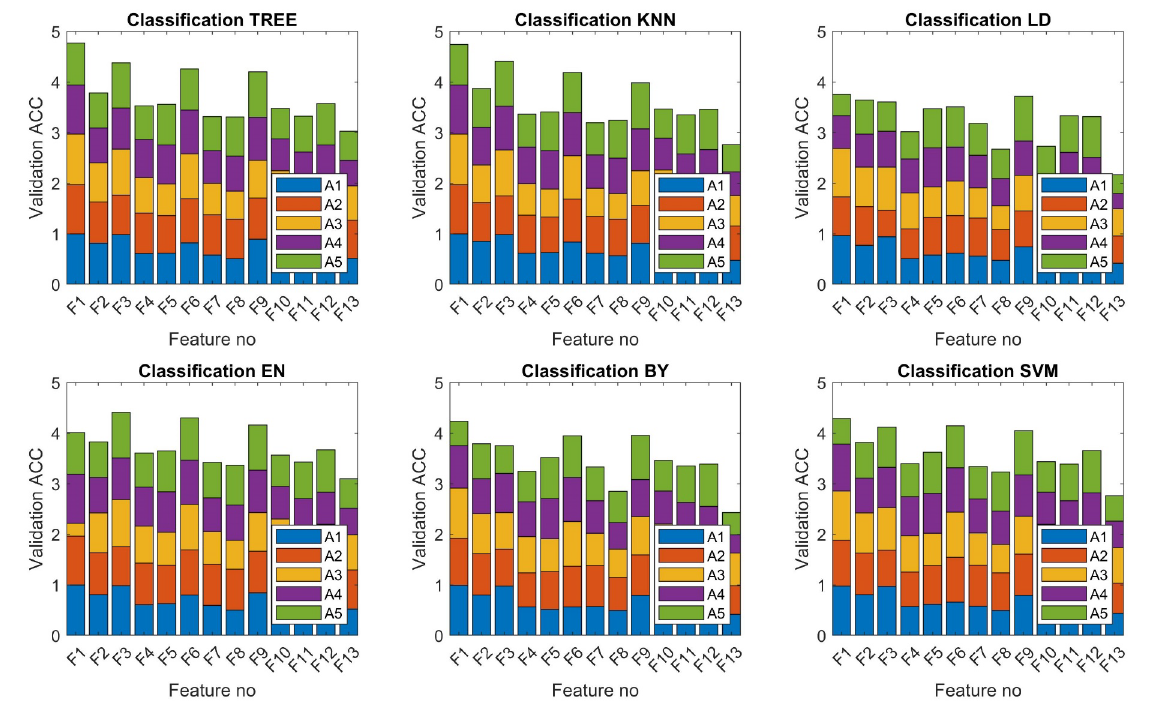
Figure 10. Stacked bar plot depicting validation accuracy values gathered for particular antenna types and features for the selected classification method.